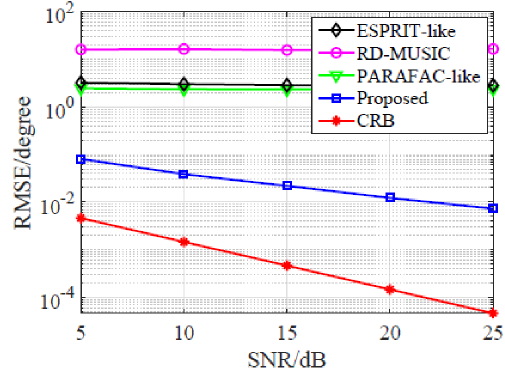
Figure 2. Average RMSE vs. SNR in Case I.